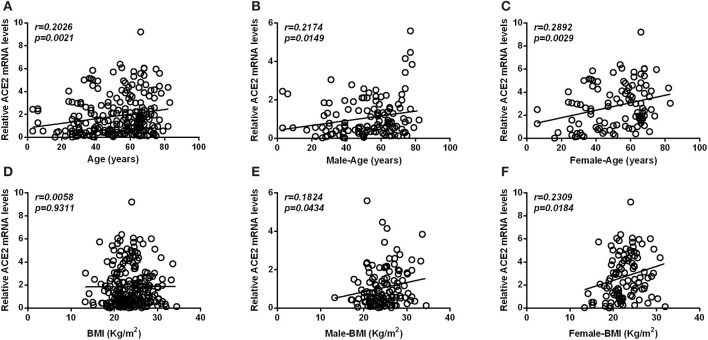
Scatterplot of patient individual measurements for age and BMI vs. ACE2 mRNA levels. (A–C) Shows the association between ACE2 mRNA levels and age, between ACE2 mRNA levels and age in male subjects, and between ACE2 mRNA levels and age in female subjects. (D–F) Shows the association between ACE2 mRNA levels and BMI, between ACE2 mRNA levels and BMI in male subjects and between ACE2 mRNA levels and BMI in female subjects. Each data point represents one patient. Pearson's analysis was used.